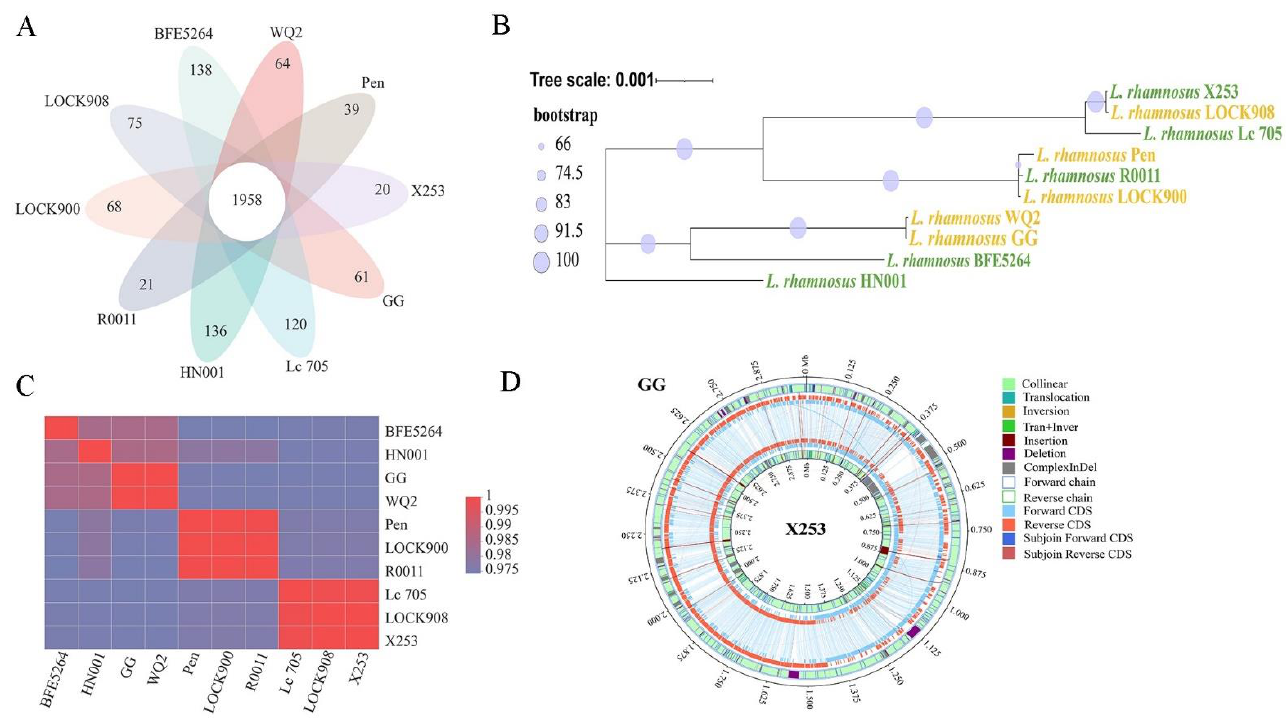
Figure 1. Comparative genomic analysis of L. rhamnosus X253 with other L. rhamnosus strains: ( A ) Venn diagram illustrating the number of genes in the core genome and unique genes of the pan-genome of 10 L. rhamnosus strains. ( B ) Phylogenetic tree constructed on single-copy orthologous genes to reveal the genetic distance of 10 L. rhamnosus strains. ( C ) Heatmap of ANI analysis of the genomes of 10 L. rhamnosus strains. ( D ) Genomic comparison between L. rhamnosus X253 and L. rhamnosus GG.